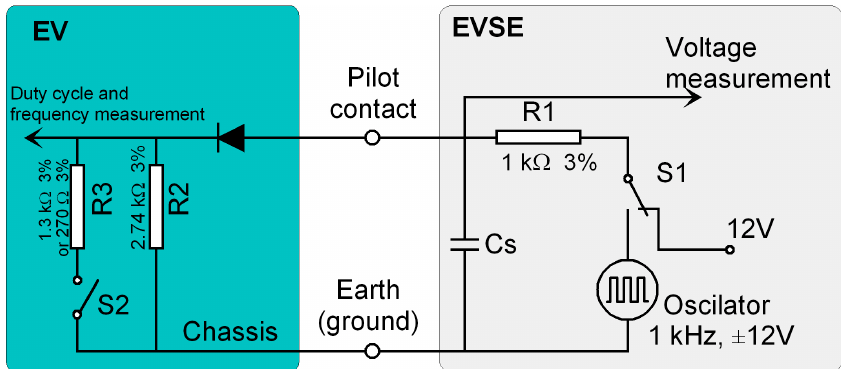
Figure 2. Typical control pilot circuit according to IEC61851-1.